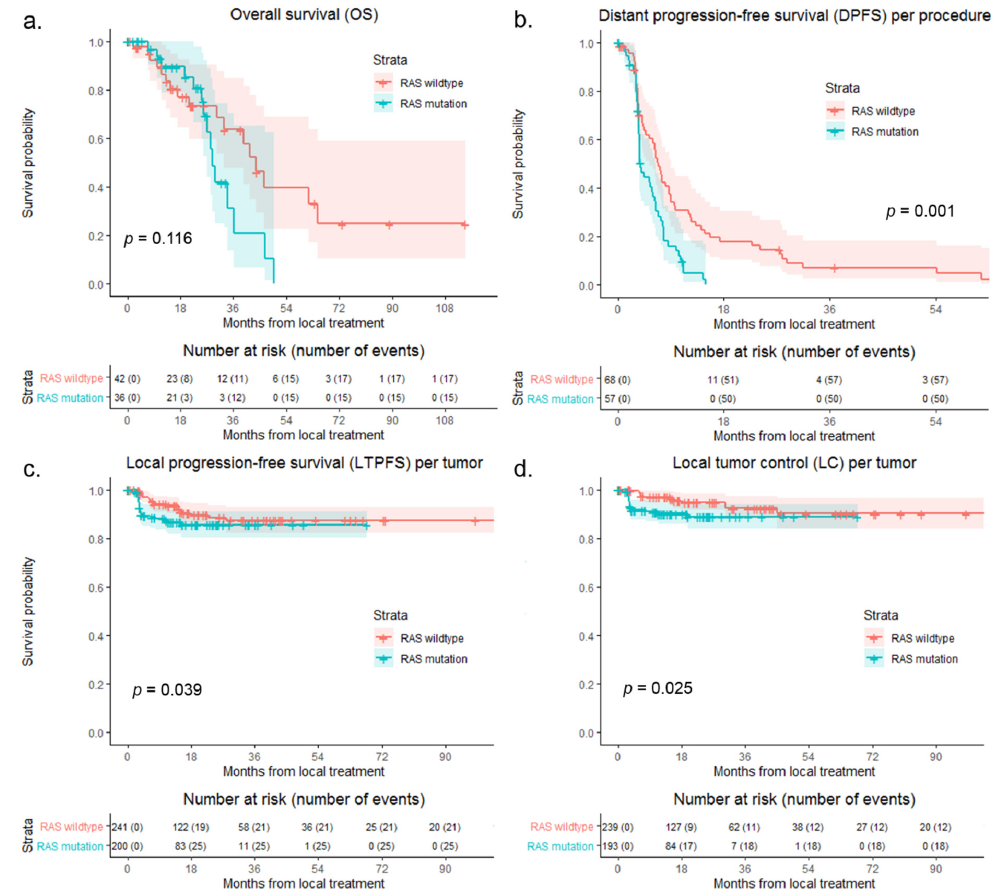
Figure 3. Kaplan–Meier curves, with log-rank (Mantel–Cox) test or Gehan–Breslow–Wilcoxon test, of ( a ) overall survival (OS) per patient ( p = 0.116), ( b ) distant progression-free survival (DPFS) per procedure ( p = 0.001), ( c ) local tumor progression-free survival (LTPFS) per tumor ( p = 0.039), and ( d ) of local control (LC) per tumor ( p = 0.025) after local treatment comparing RAS wildtype (blue) to RAS mutation (pink). Numbers at risk (number of events) are per patient, per procedure and per tumor. Death without distant progression, local tumor progression (LTP), or loss of LC (competing risk) is censored.